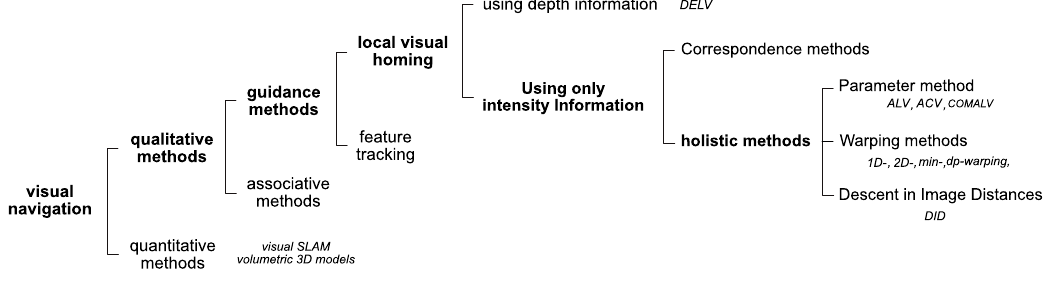
Figure 1. Overview of visual navigation. DELV, Distance Estimated Landmark Vector; ALV, Average Landmark Vector; ACV, Average Correctional